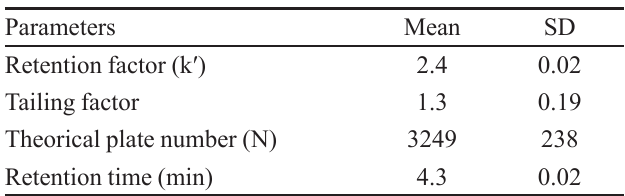
TABLE I - System suitability results according to USP 35